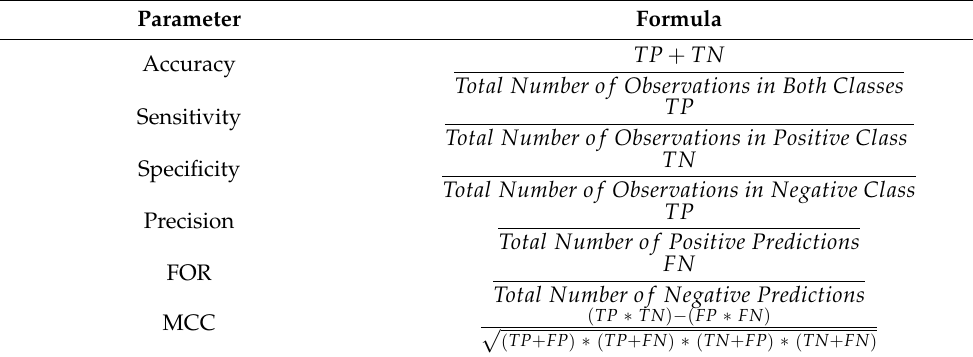
Figure 3. Format of the confusion matrix format used to report results. Number of true positives (TP), true negatives (TN), false positives (FP), and false negatives (FN) were represented and used to calculate other performance metrics. The placebo group was arbitrarily taken as the “positive” class. Table 2. Formulas for the classification performance indices.